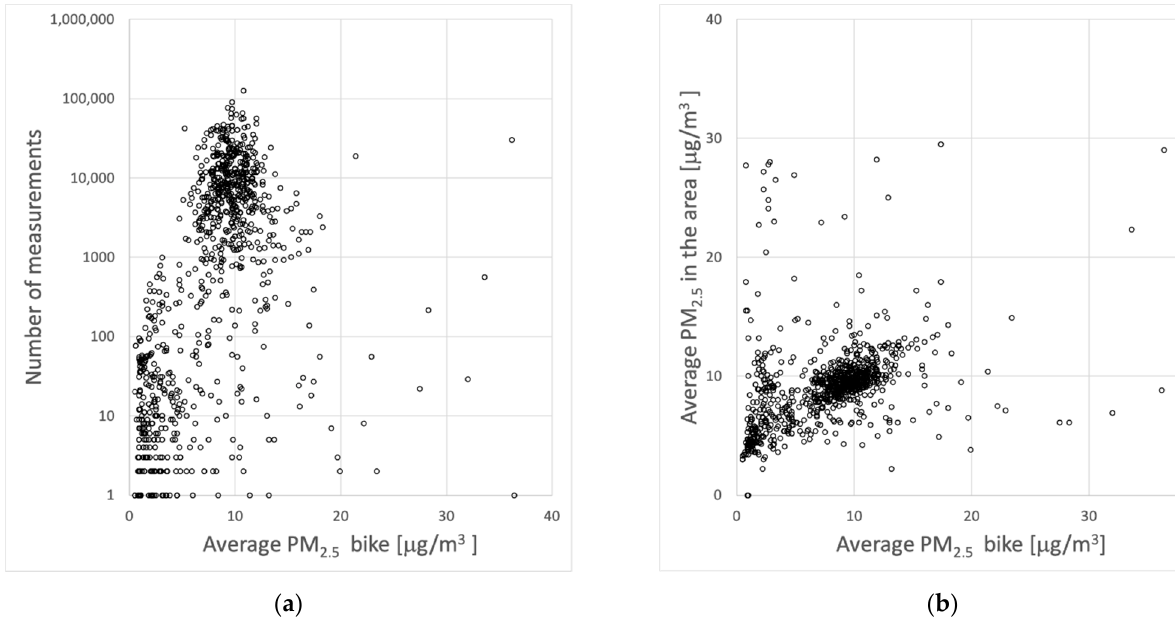
Figure 4. ( a ) The number of valid measurements of sensor kits as a function of the average concentration measured by that kit. ( b ) Average concentrations of the official measurements during the hours when each specific kit was active and compared to the average of that kit.